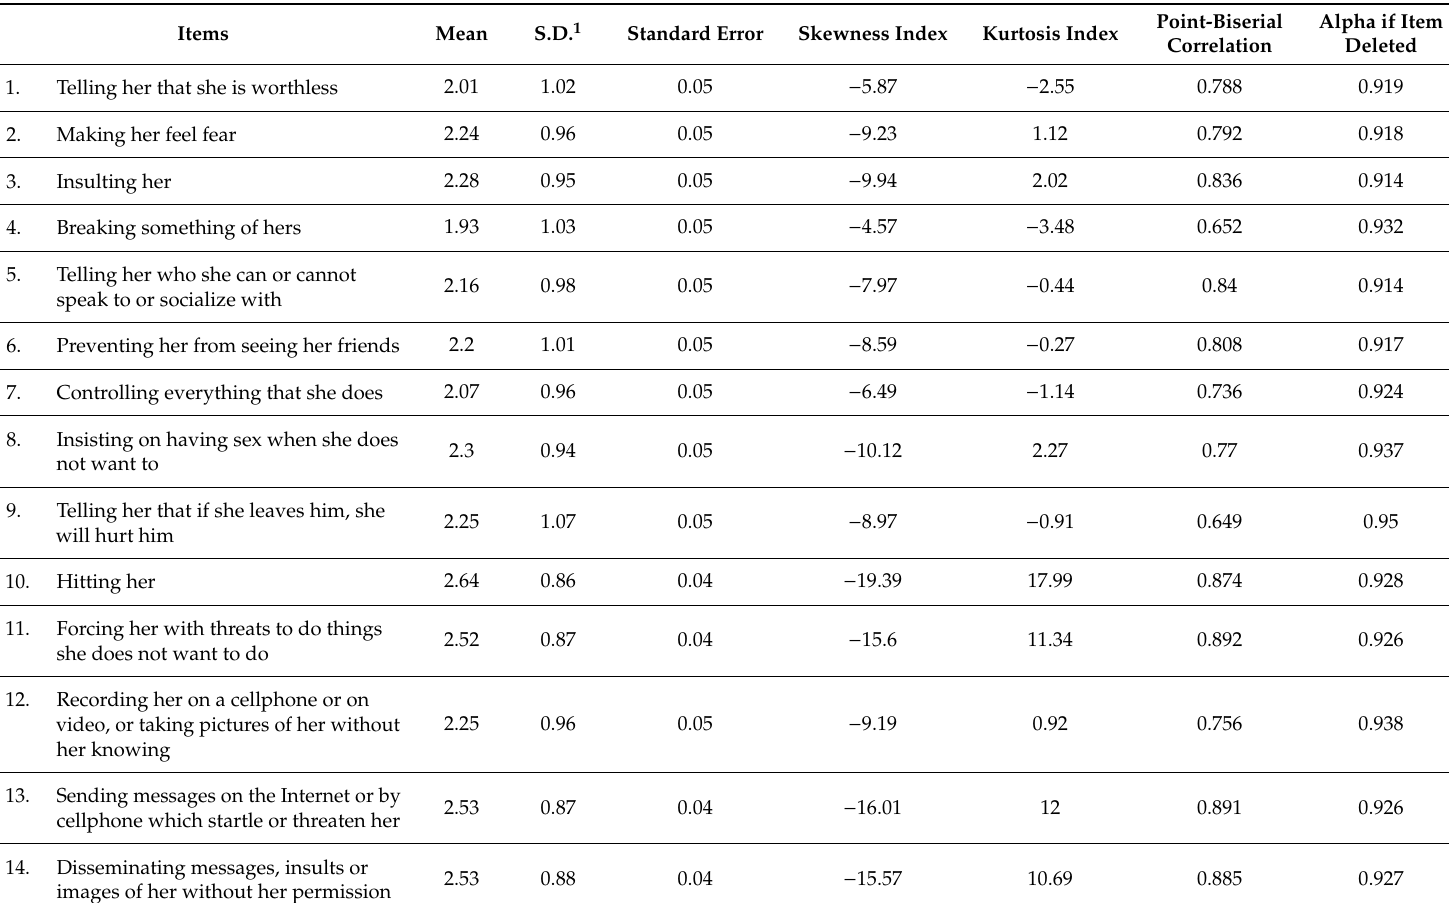
Table 1. Descriptive statistics, asymmetry and kurtosis indices, and biserial-punctual correlation for each item from the di ff erent subscales of the Questionnaire of Perception of Inter-Partner Violence from boy-to-girl. Items from 1 to 7 measure emotional abuse, items from 8 to 14 measure multiple